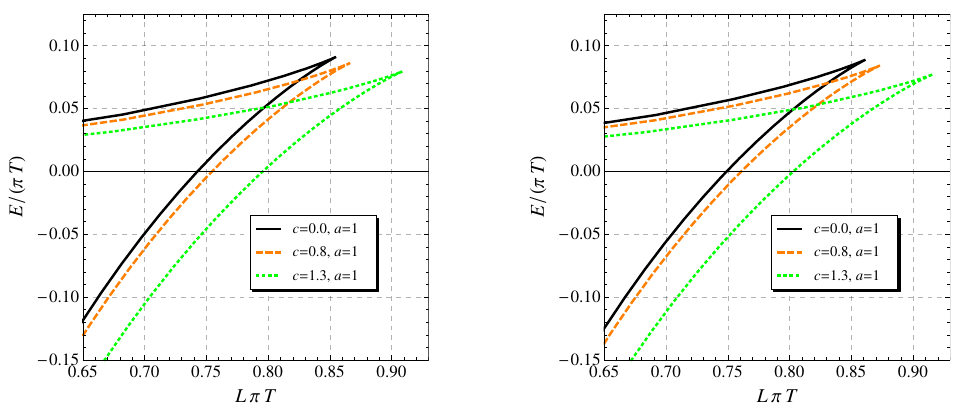
Figure 11 . The binding energy of the q (cid:22) q -pair aligned parallel (left) and perpendicular (right) to the anisotropic z -direction for di(cid:11)erent values of the deformation parameter c . We can again see that the screening distance grows with c which comes together with lower values of E ( L ). We can also see that the e(cid:11)ect of c is the same in the two